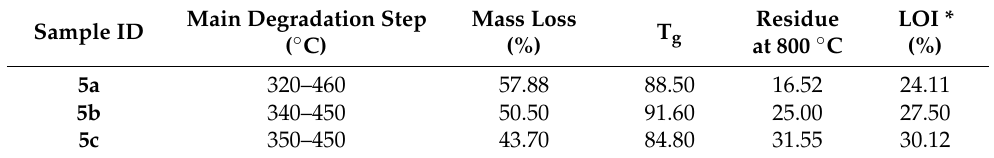
Table 3. Thermal degradation parameters for 5a – c